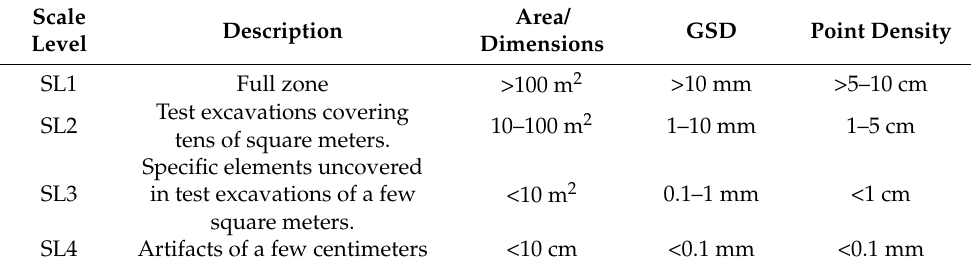
Table 1. Summary of the scale levels considered in this